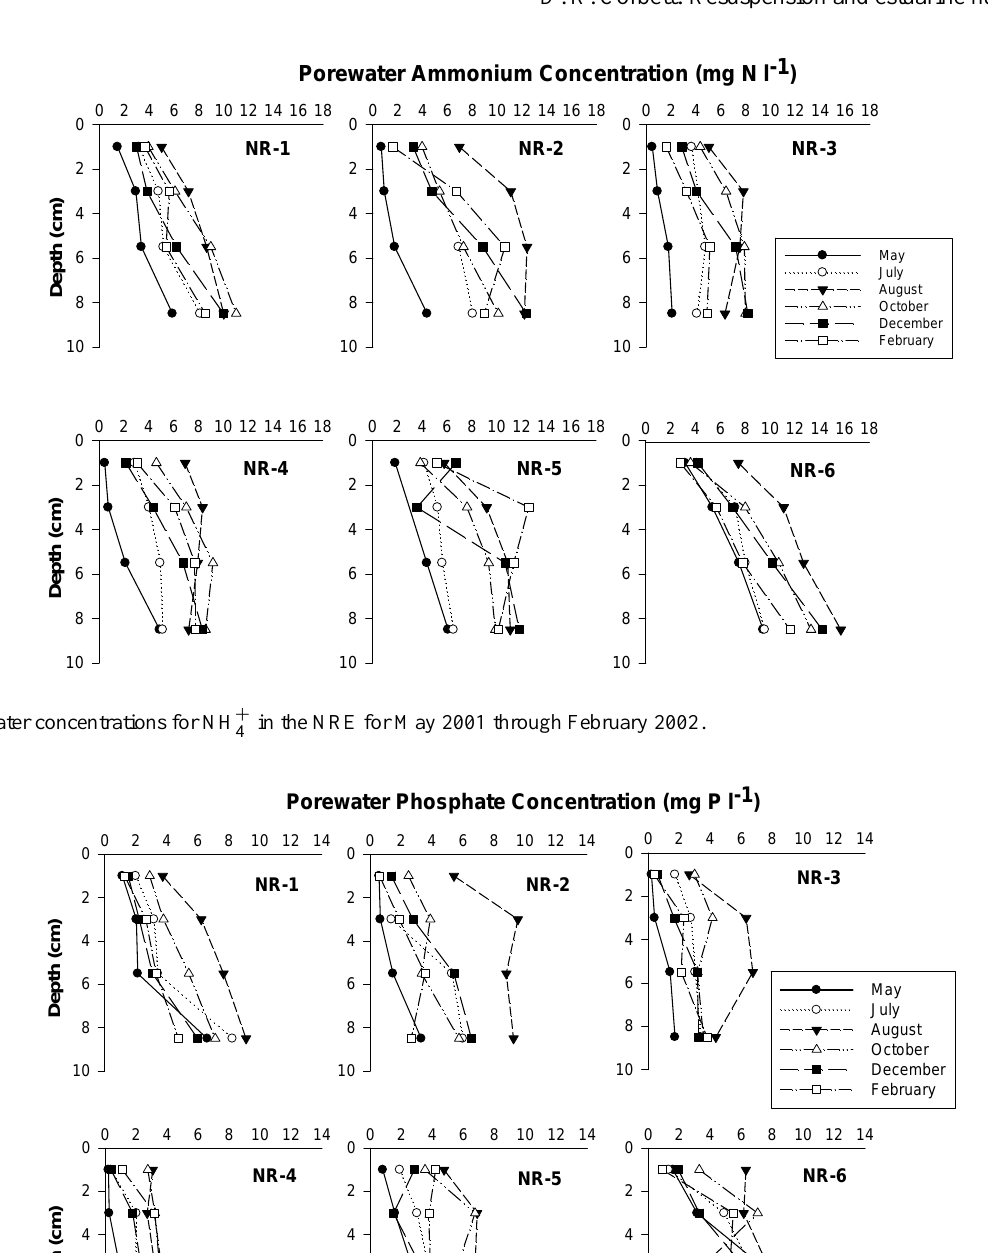
in the NRE for May 2001 through February 2002. 4